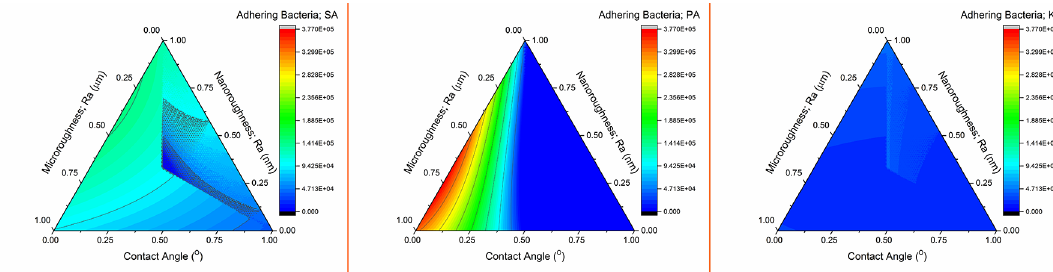
Figure 13. A comparison among the adhesion of the Staphylococcus aureus (SA), Pseudomonas aeruginosa (PA), and Klebsiella pneumonia